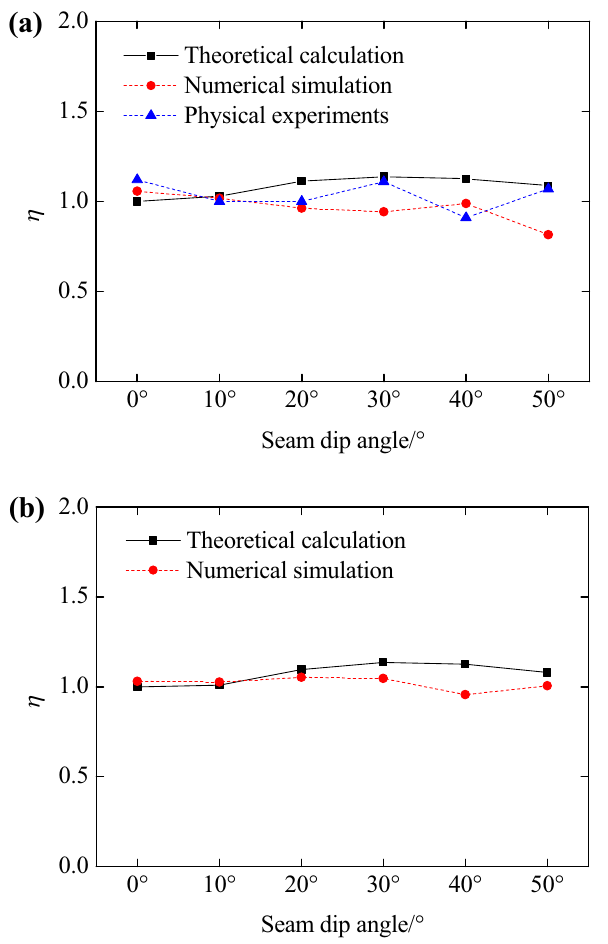
Fig. 18 Volume symmetry coefficients obtained from theoretical calculation, numerical simulation, and physical experiments: a initial drawing stage; b normal drawing